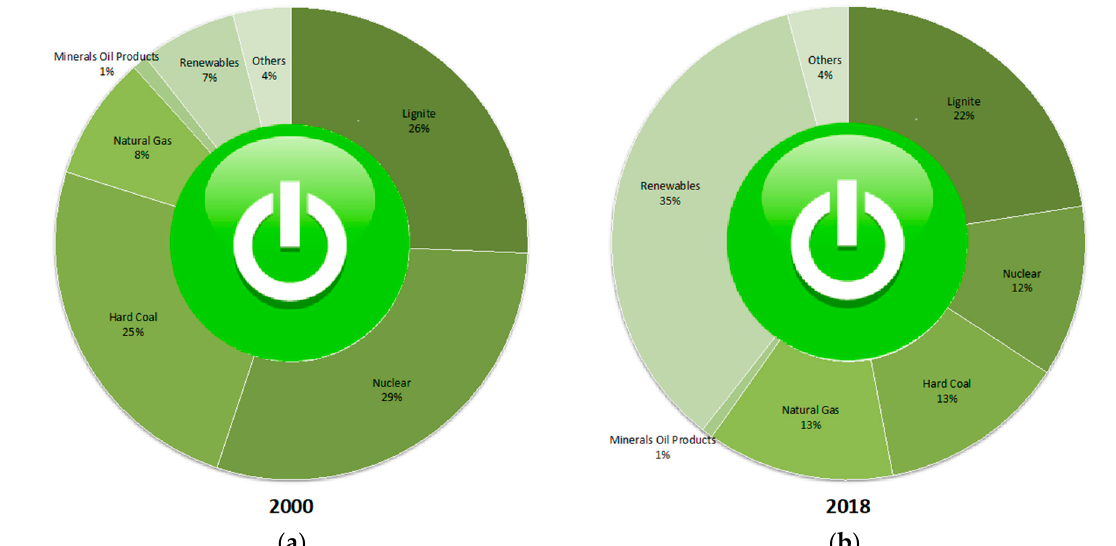
Figure 4. Comparison of electricity generation in Germany by energy source in ( a ) 2000 and ( b ) 2018 Source: BDEW Federal Association of Energy and Water Management, Working Group on Energy Balances (German: Arbeitsgemeinschaft Energiebilanzen), Federal Ministry for Economic Affairs and Energy, Center for Solar Energy and Hydrogen Research, and coal industry statistics. Source: Statista ID: 156695, statista.com.